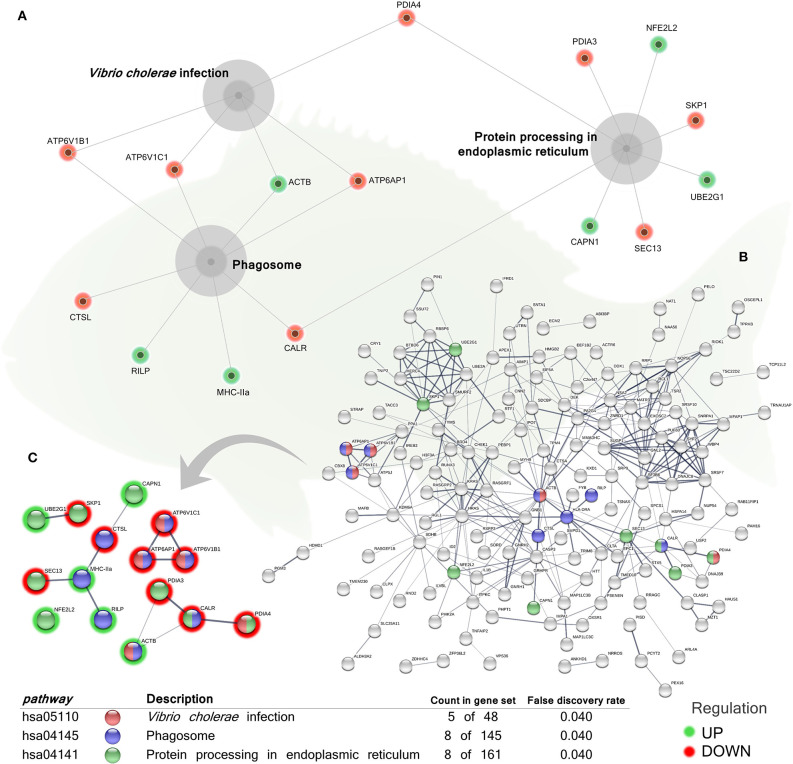
Kyoto Encyclopedia of Genes and Genomes (KEGG) pathways networks of the differentially expressed genes (DEGs) in the skin of juvenile gilthead seabream (Sparus aurata) fed a diet supplemented with a blend of garlic essential oil, carvacrol and thymol. (A) Gray cores represent the KEGG pathways significantly impacted by the DEGs obtained from the skin of fish fed the phytogenic-supplemented diet. Green-shaded nodes represent up-regulated genes and red-shaded nodes represent down-regulated genes. (B) Nodes colors indicate the KEGG pathways for each DEG represented within the overall transcripteractome. Pathways description, count of DEGs within each pathway and respective false discovery rate are described in the graphical figure legend. (C) Interactions exclusively among the DEGs within each KEGG pathway. Nodes colors indicate the KEGG pathways for each DEG represented. Pathways description, count of DEGs within each pathway and respective false discovery rate are described in the graphical figure legend. Green-shaded nodes represent up-regulated genes and red-shaded nodes represent down-regulated genes. For details, please refers to Supplementary Table 3.